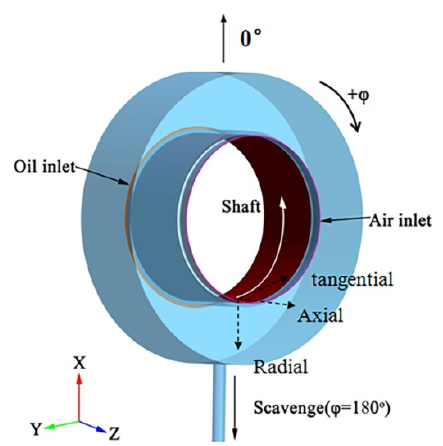
Figure 3. Geometric model of the ventless bearing chamber.